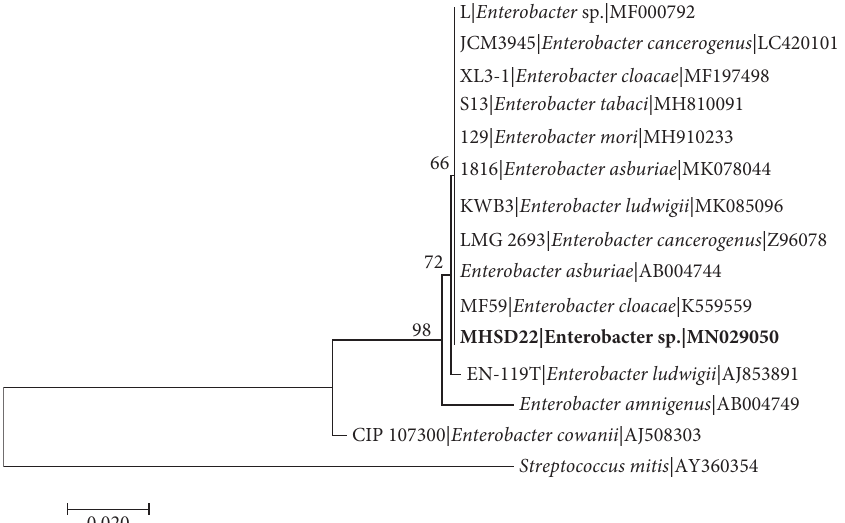
Figure 2: Maximum likelihood phylogenetic tree based on analysis of partial 16S rDNA nucleotide sequences of Enterobacter sp. strain MHSD22 with related strains from Enterobacter genus. Numbers above or below the nodes indicate bootstrap values generated after 1000 replications. Streptococcus mitis (AY360354) was used as an outgroup. RJ13| Stenotrophomonas maltophilia |KM279660